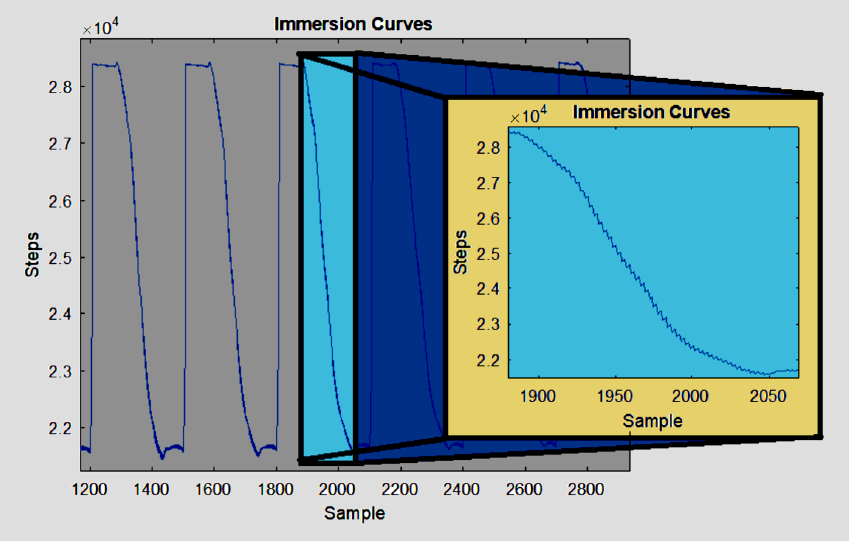
Figure 3. Curves measured by the water level sensor during submersion showing tiny damped step functions to be used as the AC signal in the lock-in